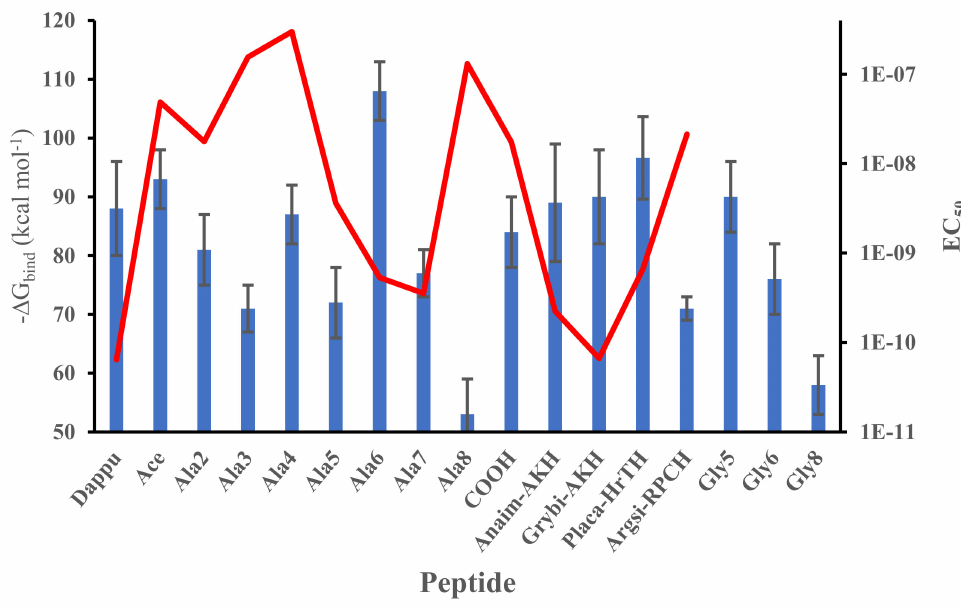
Figure 3. Free energy of binding of mutated Dappu-RPCH to Dappu-RPCHR during the last 30 ns of a 50 ns trajectory in a POPC membrane (blue bar). Error bars are the standard deviation of the mean. EC 50 values (red line) [13] are not available for some of the